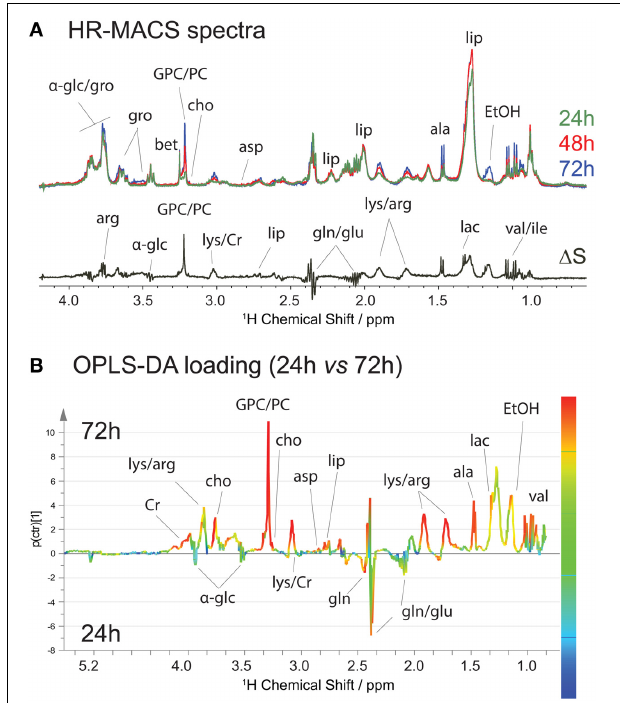
FIGURE 4 | 1 H HR-MACS NMR study of cell growths. (A) Spectral comparison composed of averaged spectra (with n = 5): green corresponds to cell growth at 24-h; red at 48-h; and blue at 72-h. The (cid:3) S spectrum is the spectral difference between 72 and 24-h cells. The positive peaks correspond to the increased in metabolite contents in 72-h cells, and the negative peaks in the 24-h cells. Both the assignments and abbreviations are listed in Table S1. (B) OPLS-DA loading with Q 2 = 0 . 986, R 2 Y(cum) = 0.986 and R 2 X(cum) =